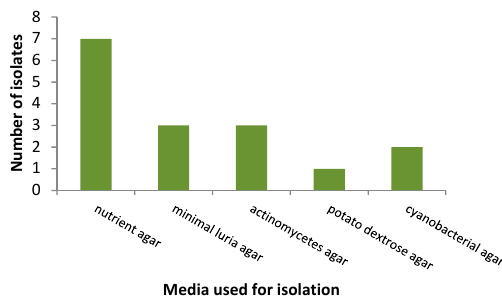
Figure 2. Comparison of number of isolates obtained on different media.